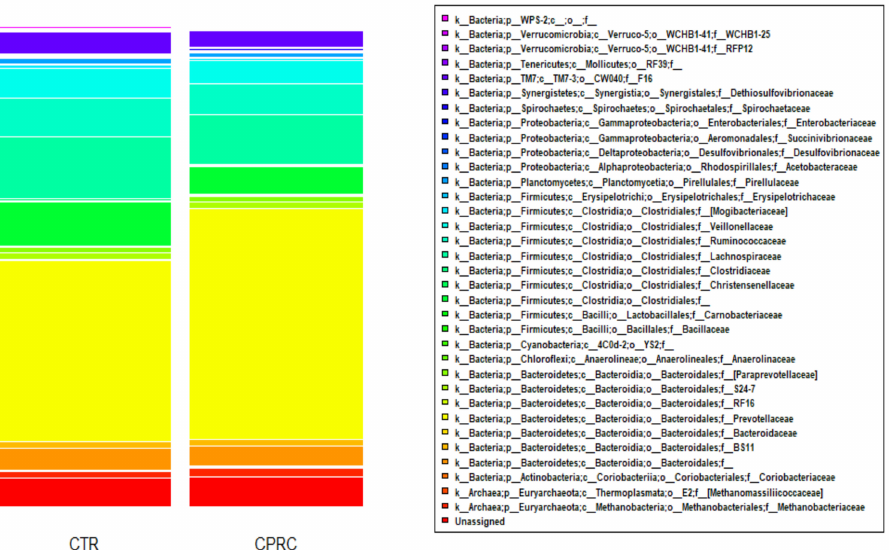
Figure 1. Bacterial community composition at the family level in the ruminal samples of cows ( n = 18) when fed a control concentrate (CTR) and a concentrate with cold-pressed rapeseed cake (CPRC).